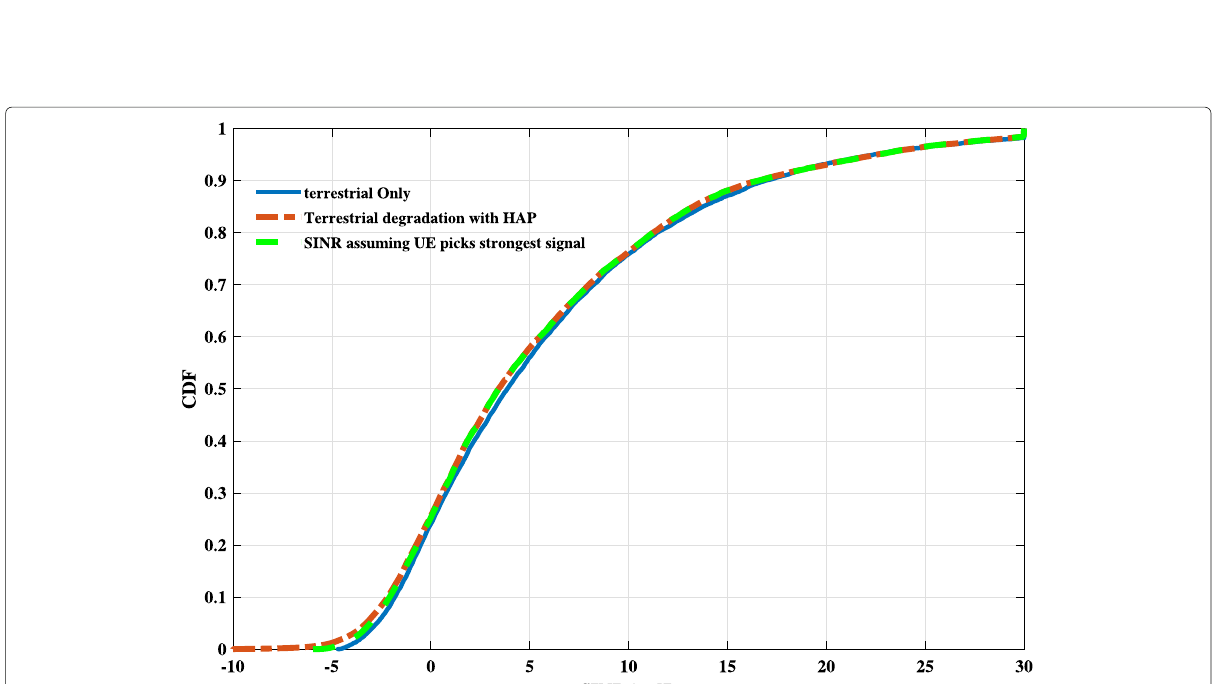
Fig. 9 CDF of SINR before and after placement of a Loon HAP over a 37 cell terrestrial rural